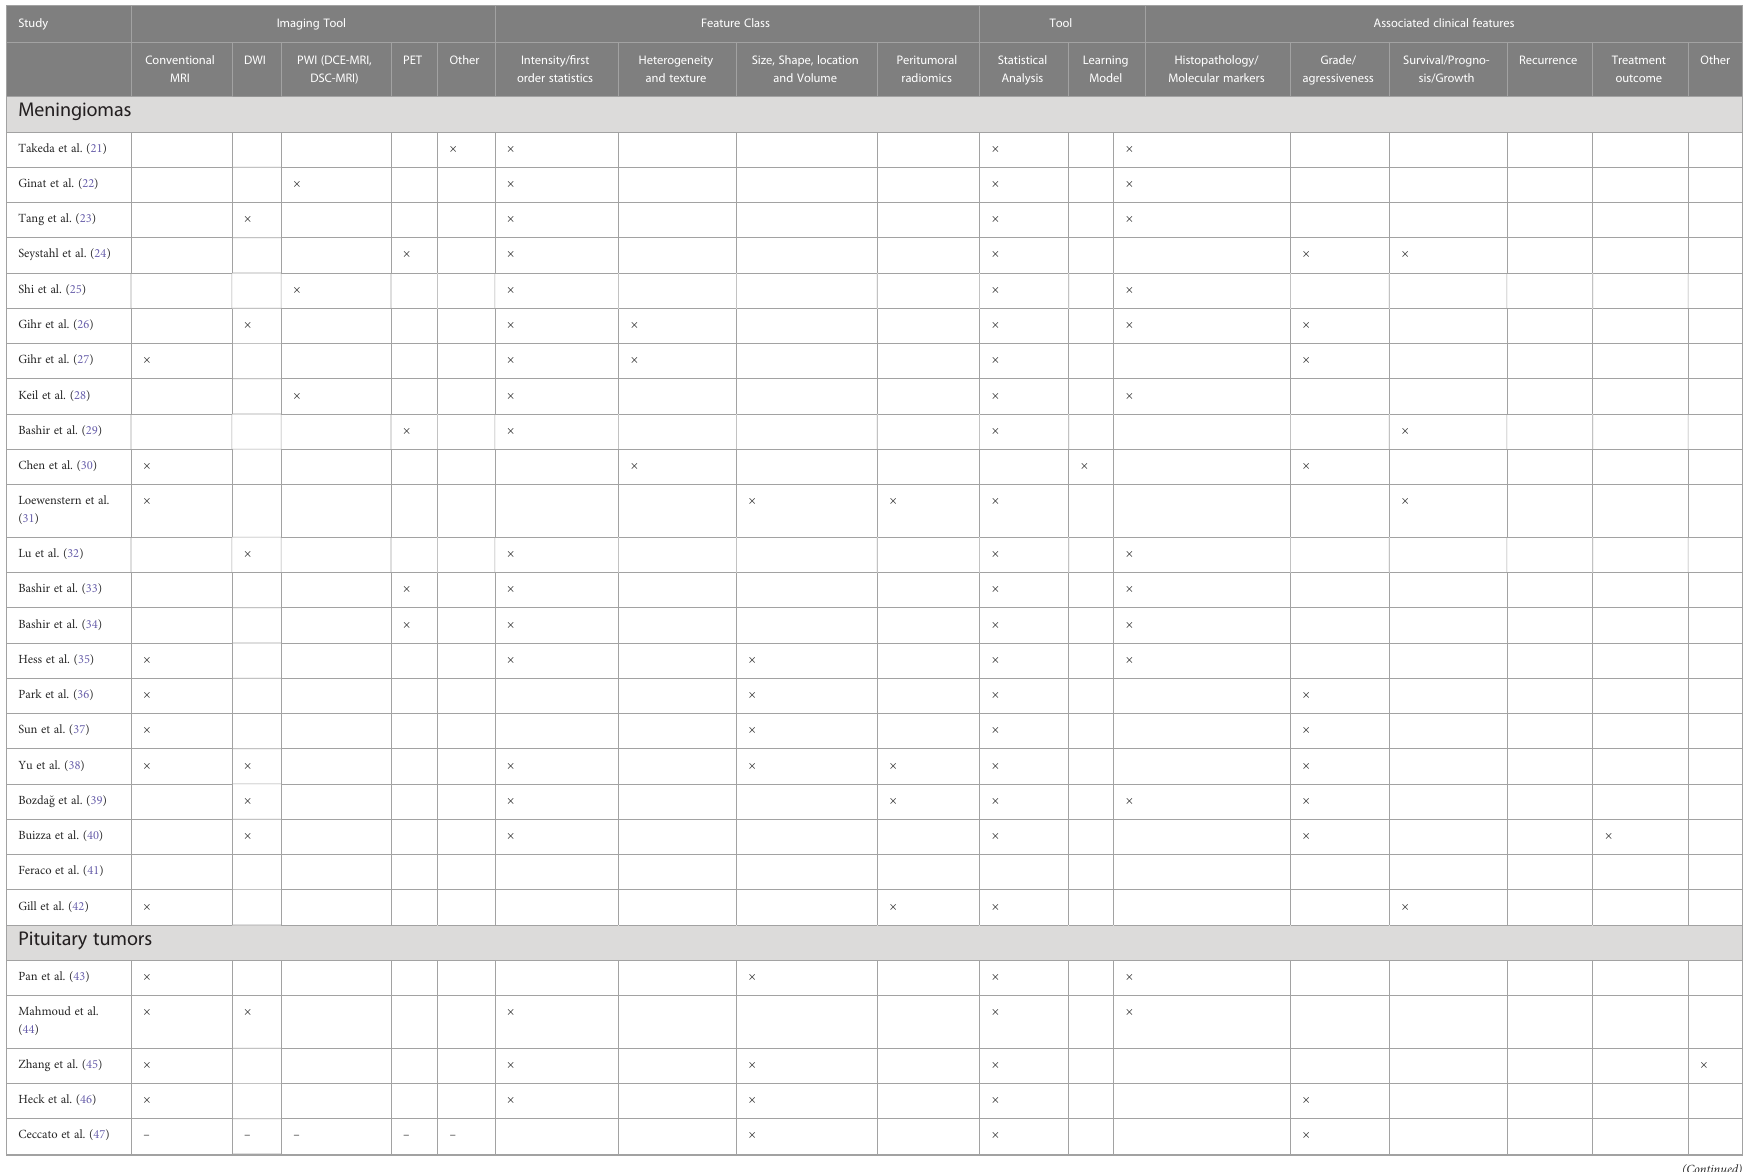
TABLE 1 Summary of the included